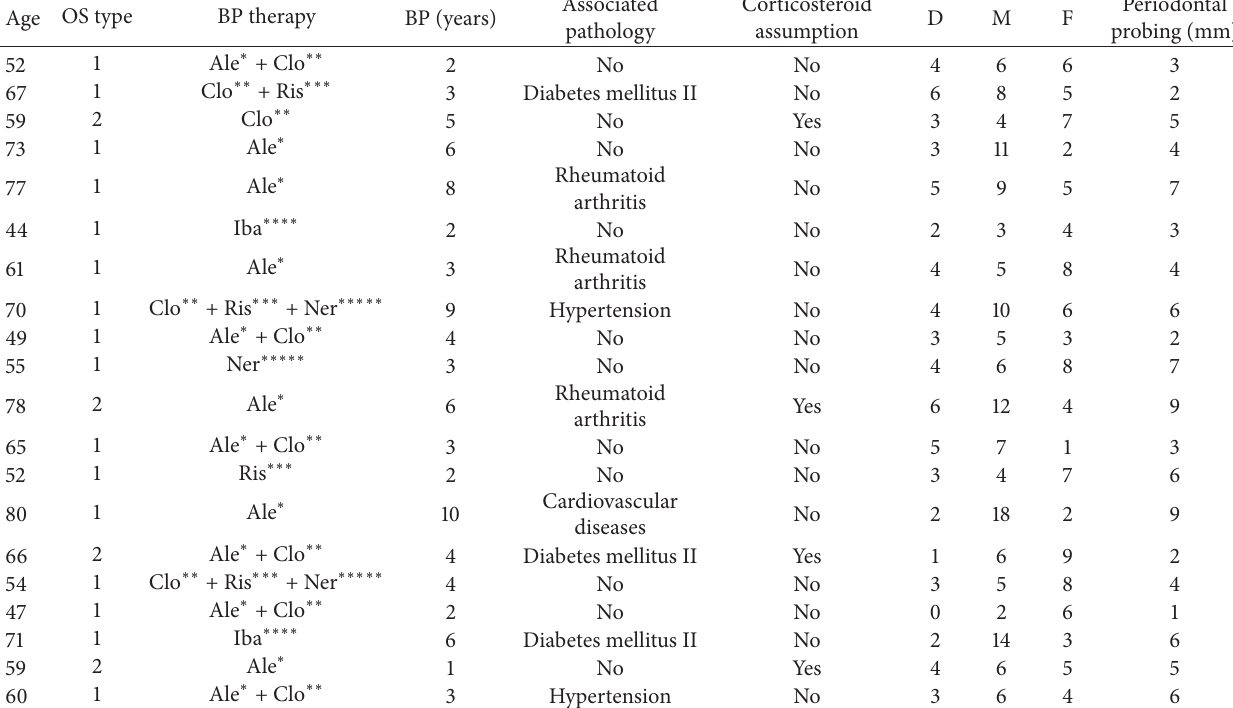
Table 1: Anamnestic and clinical details of A Group—20 osteoporotic non-BRONJ